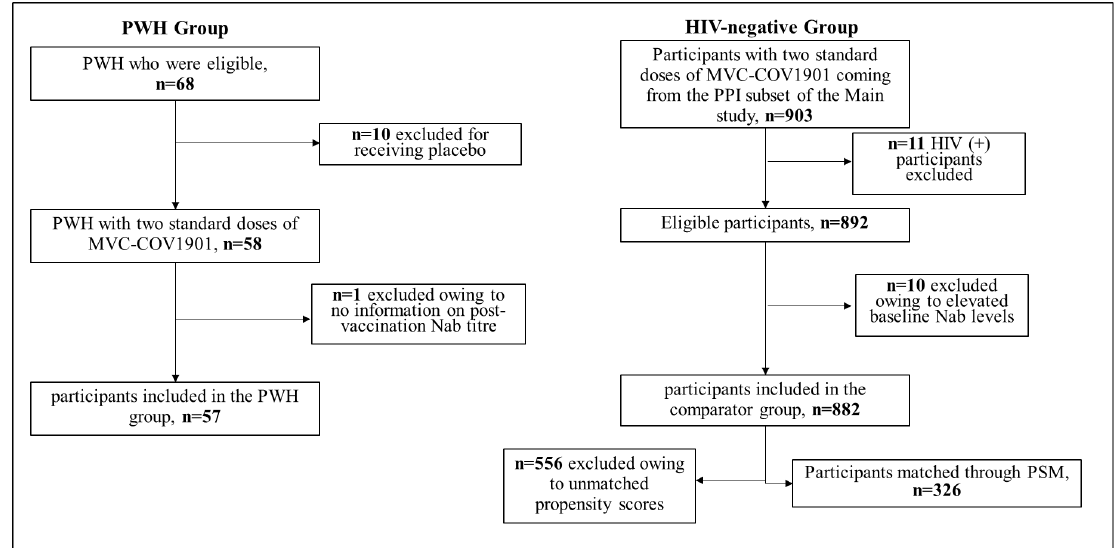
Figure 1. The algorithm of the PWH group and the HIV-negative group receiving the MVC-COV1901 protein vaccine. Abbreviations: PWH = People Living with HIV; Nab = neutralizing antibodies; HIV = Human Immunodeficiency Virus; PSM = Propensity Score Matching